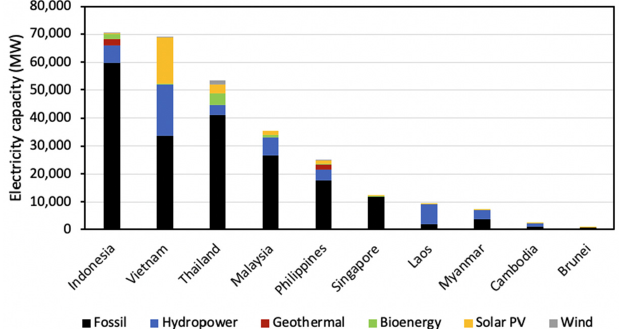
Figure 16. ASEAN electricity capacity by type in 2019 [22] .